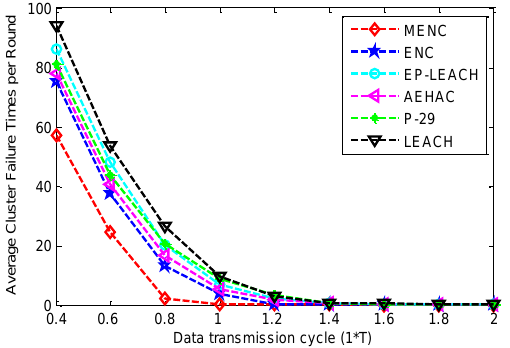
Figure 5. The comparison of ACFTR among MENC, ENC, EP-LEACH, AEHAC, P-29 and LEACH for different data transmission cycles.